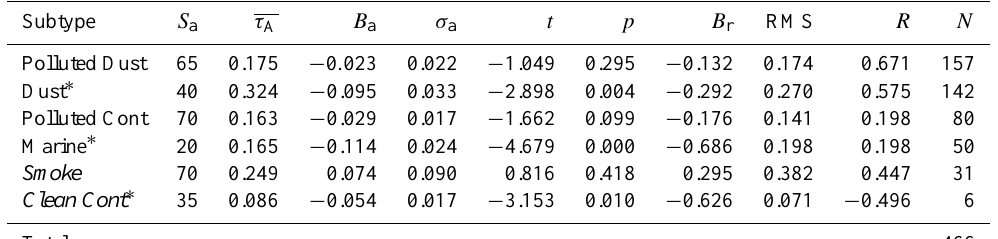
Table 2. Lidar ratios ( S a ) at 532nm and statistics for aerosol optical depth comparisons for different aerosol subtypes (as defined by CALIPSO). Maximum closest approach is 80km. Average AERONET aerosol optical depth ( τ A ) at the 0.532µm wavelength, absolute bias and standard error ( B a , σ a ), student’s t-test score and p -value ( t , p ), relative bias ( B r ), root-mean-square error (RMS), correlation coef- ficient ( R ), and number of comparisons ( N ). Regions denoted with ( ∗ ) indicate absolute biases that exceed the 95% confidence interval of the means (i.e., t-score magnitudes greater than 2 and p -values less than